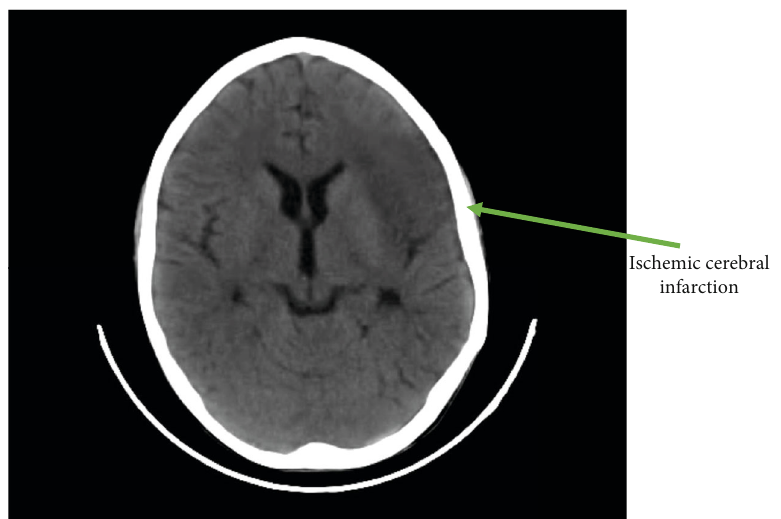
Figure 2: A cerebral CT scan revealing a hypodense lesion on the left frontal lobe indicating a recent ischemic cerebral